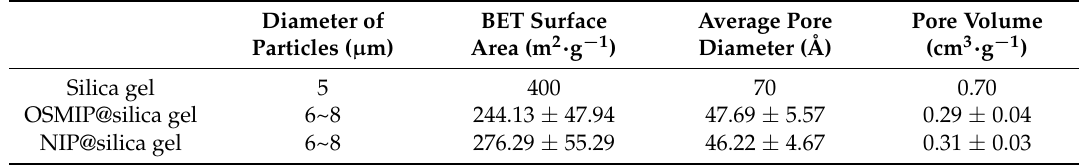
Table 1. Diameter of particles, Brunauer, Emmett and Teller (BET) surface area, average pore diameter and pore volume of silica gel, OSMIP@silica gel and its corresponding NIP@silica gel ( n =